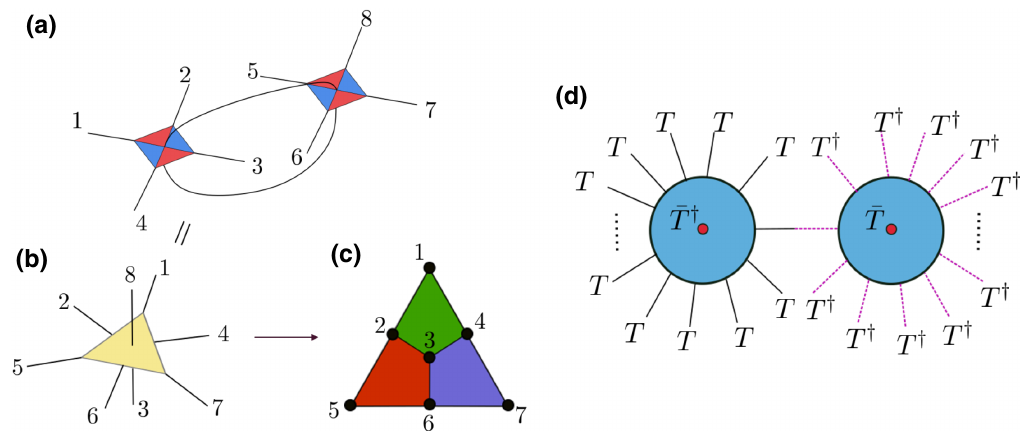
FIG. 6. (a) Tracing together the “logical” degrees of freedom in two [[4, 2, 2]] codes produces (b) an eight-legged tensor. Without loss of generality, we choose leg number eight to be a logical degree of freedom. Then it becomes an encoding isometry of the Steane code [58] (c) where stabilizer generators are XXXX , ZZZZ acting on the four vertices of each of the colored faces. Logical X and Z operators are all X and all Z operators acting on all seven vertices. (d) Because the 15-qubit Reed-Muller code has a transversal T gate, we can easily deduce from operator pushing that the code by tracing two such tensors would also have a transversal non-Clifford gate. Here the red dots represent dangling logical legs and ¯ T † ¯ T can be pushed to the boundary dangling legs where T acts on the black solid lines and T † acts on the purple dashed lines.